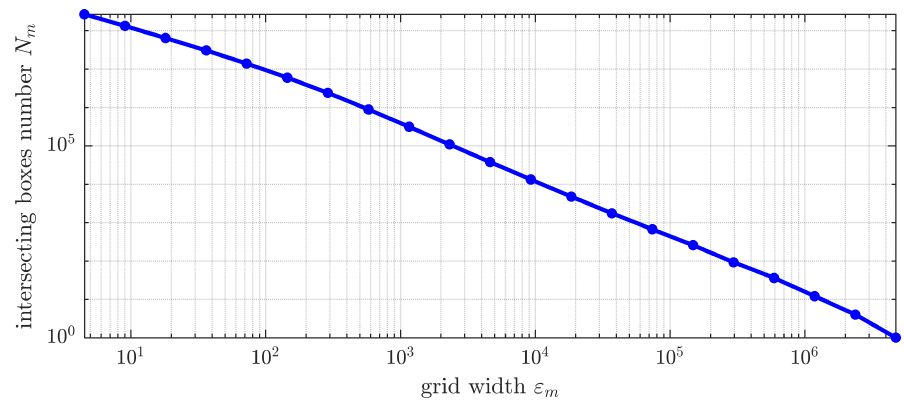
Figure 6. Log-log plot of intersecting boxes number versus grid